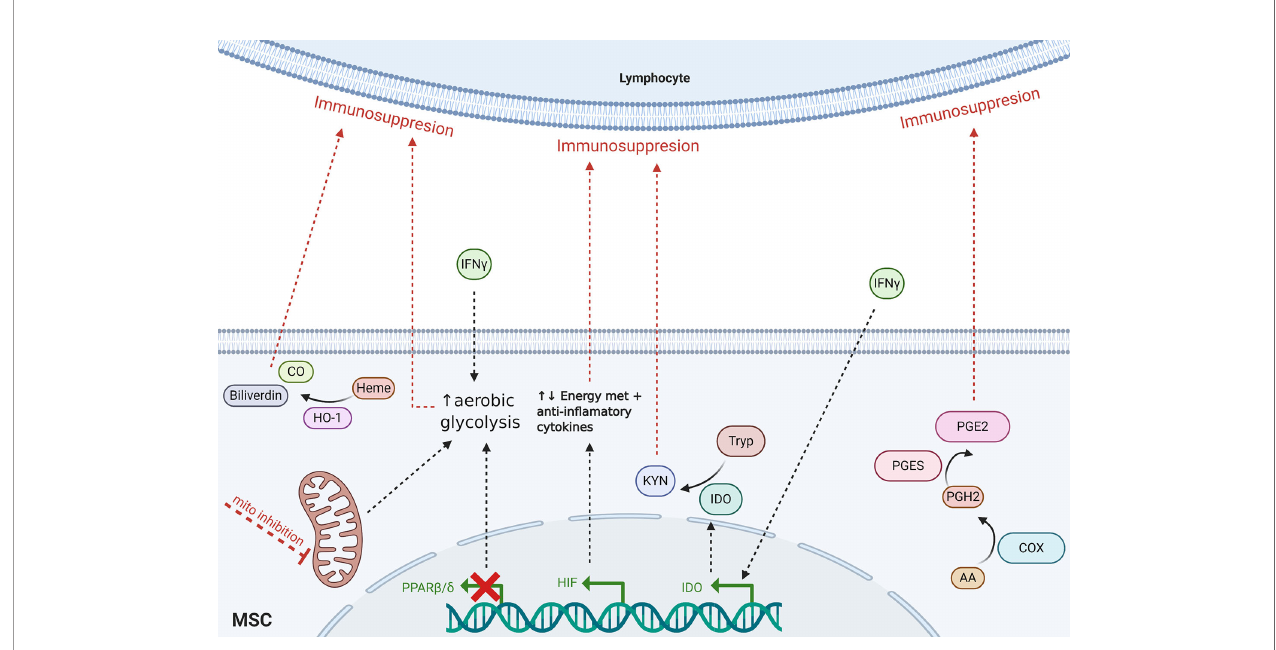
FIGURE 1 | Schematic of proposed MSC-mediated metabolic immunomodulatory mechanisms reviewed herein. Dotted lines indicate incompletely understood mechanisms. Tryp, tryptophan; Kyn, kynurenines; CO, carbon monoxide; AA, arachidonic acid; mito, mitochondria; met,